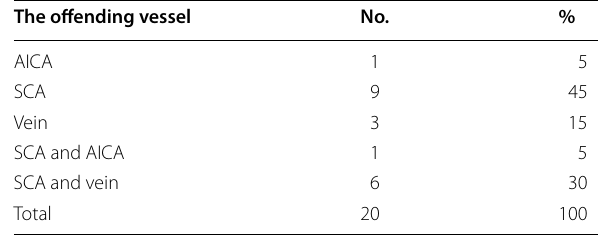
Table 3 Distribution of the studied sample according to the offending